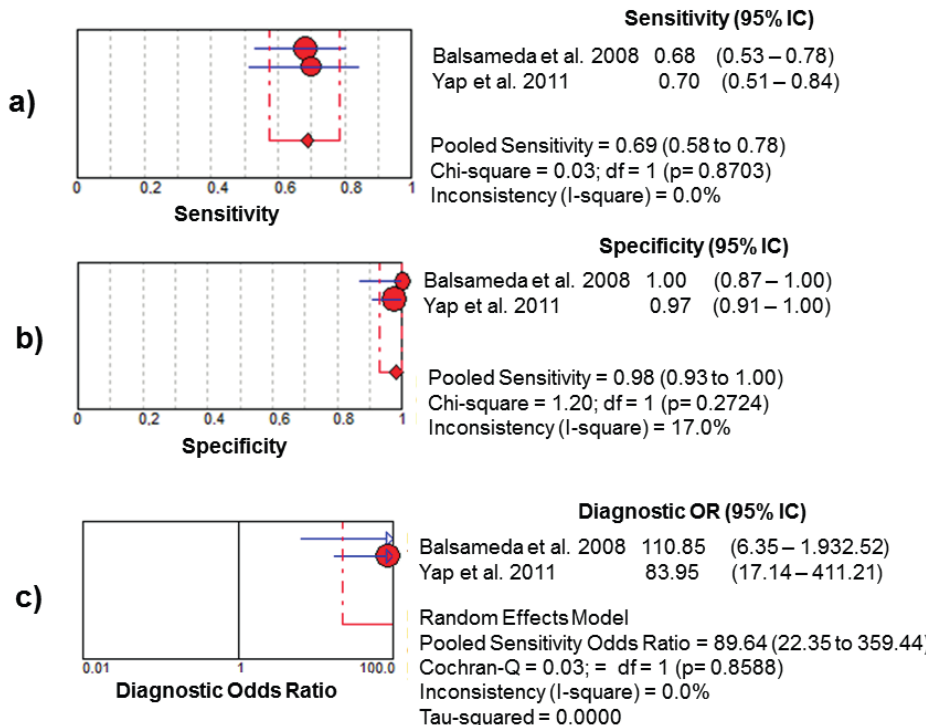
Figure 5 - Forest plot of sensitivity, specificity and diagnostic odds ratio of